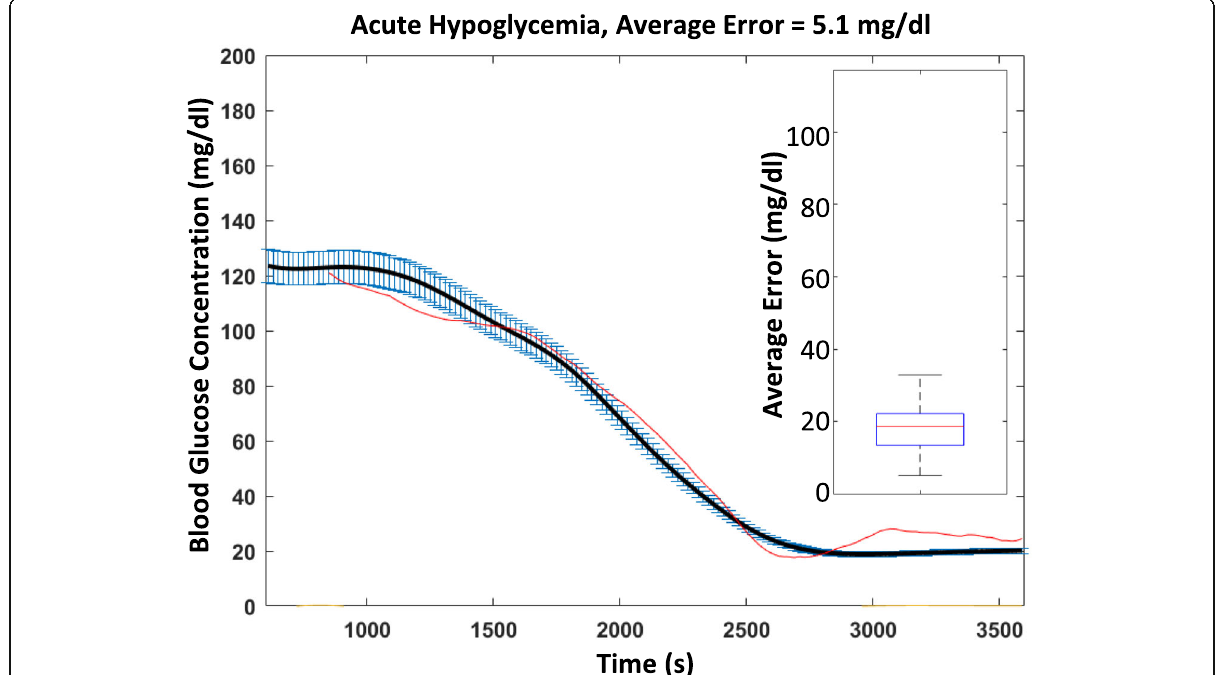
Fig. 4 Indicative wild type regression model performance from an insulin injection. The black line indicates the smoothed blood glucose measurements, with blue bars indicating interpolation error. The red line indicates the estimated blood glucose levels as an output of the regression model. The regression closely traces the smoothed blood glucose measurements, and the average error over the N =6 subjects has an interquartile range between 14 and